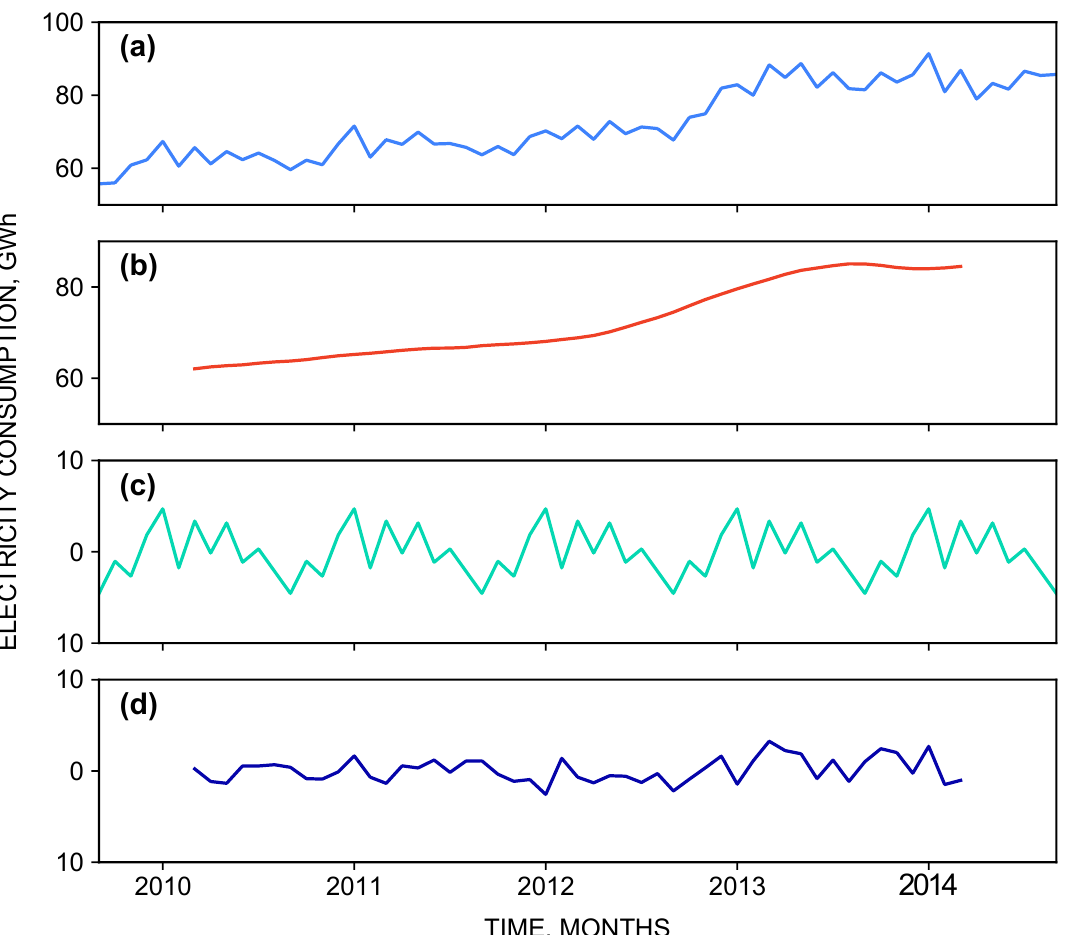
Figure 3. Decomposition of total electricity consumption (GWh) in the Thames Water Utilities Ltd. system: ( a ) the observed time series f ; ( b ) the trend α ; ( c ) the seasonal phase β ; and ( d ) the random component γ